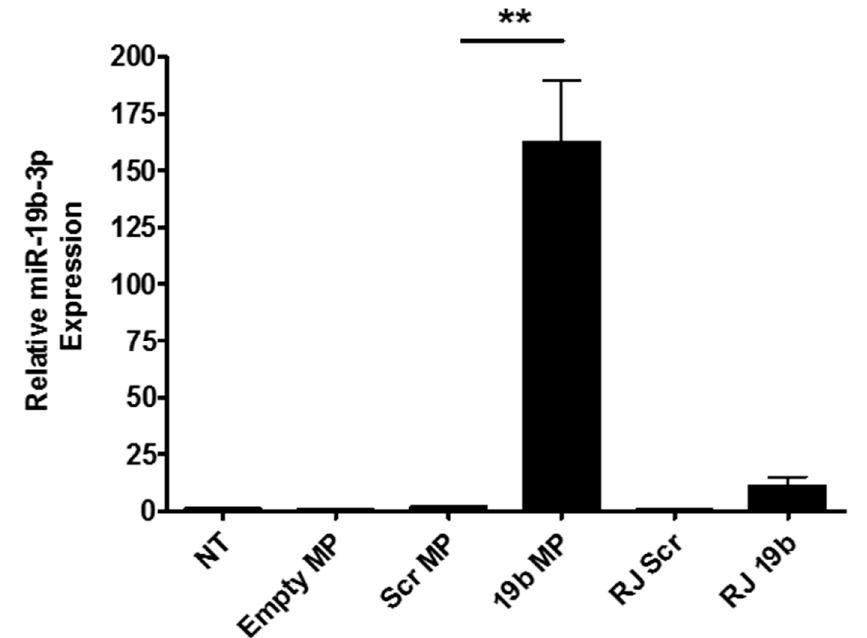
Figure 2. The effects of PLGA microparticles on the levels of mature miR-19-3p in phorbol myristic acetate (PMA)-differentiated U937 macrophages post transfection, as determined by qRT-PCR. Cells were treated, in triplicate, with empty MPs, MPs containing scrambled non-targeting control miRNA (Scr) or pre-miR19b (19b) or RiboJuice™ (RJ) controls at an RNA concentration of 30 nM. Cells were washed and media was replaced after three hours, and cells were lysed at 72 h post transfection. Results (mean + SEM) are normalised to U6 RNA expression. NT: non-transfected, data representative of three experiments (** p ≤ 0.01, one-tailed t test).